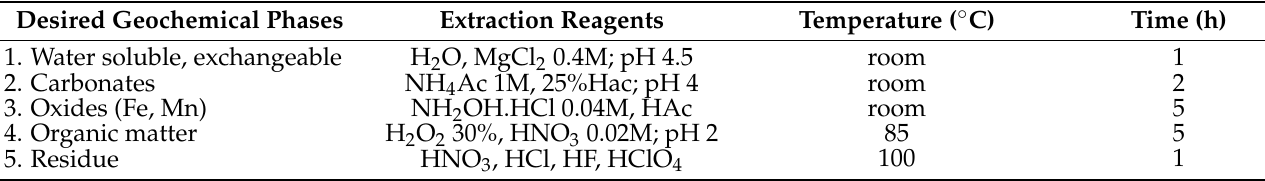
Table 11. Typical sequential extraction reagents and conditions for the fractionation of 241 Am in soil and sediment.